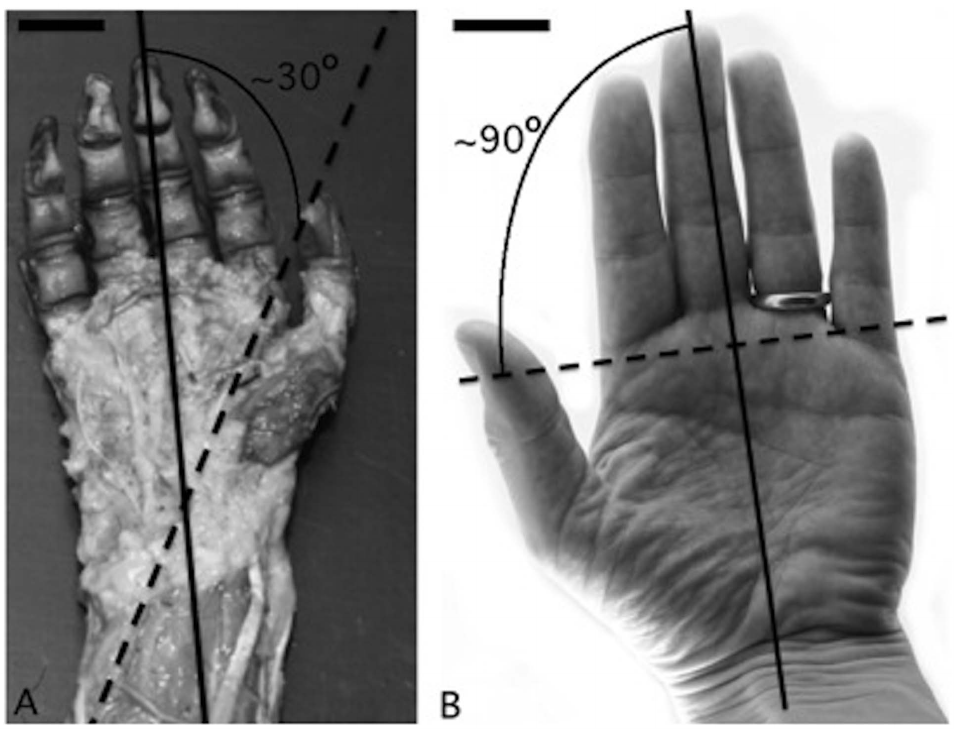
Figure 6. Nail-pulp and medial axes’ angle comparison. (A) Photograph of a capuchin’s right hand, dissected (bar=0.5 cm) and (B) human left hand (bar=1.2 cm). Note that the angle formed by the crossing of the axes is of approximately 30 u in capuchins and approximately 90 u in humans.